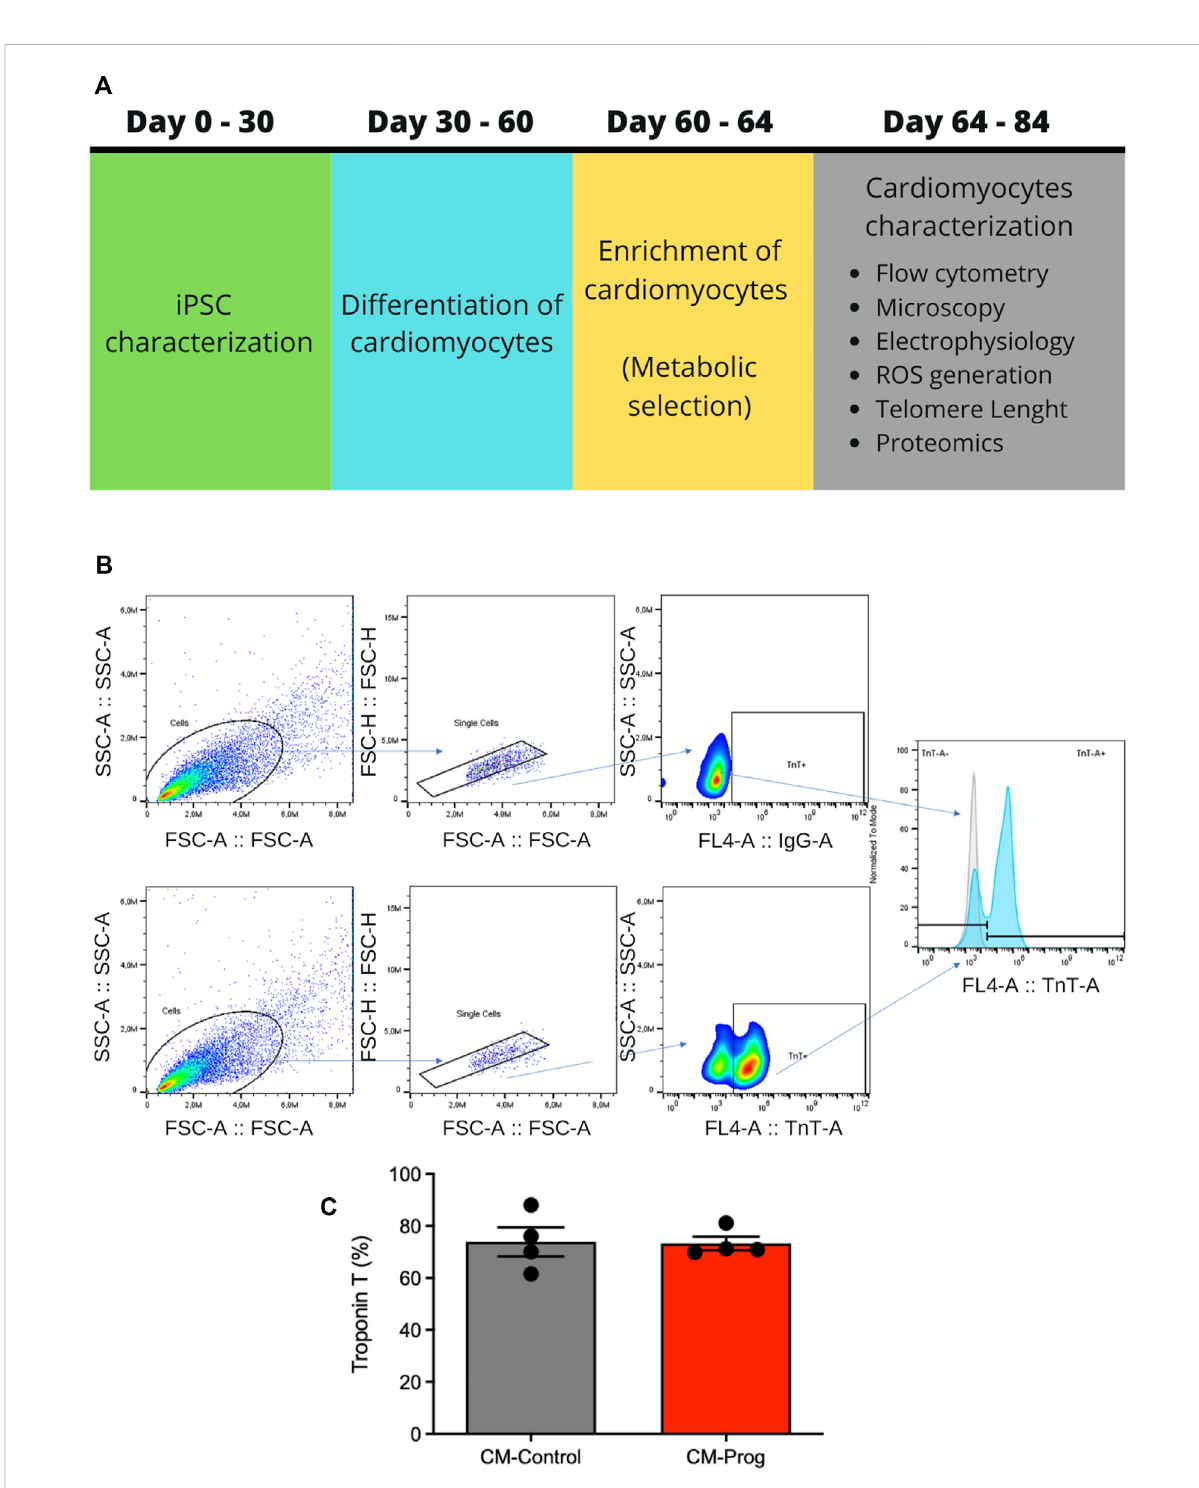
FIGURE 1 Study design and iPSC-derived cardiomyocyte generation (A) Schematic representation of the study design. (B) Gate strategy is shown in fl ow cytometry analysis of Troponin T (TnT) expression on cardiomyocytes derived from iPS cells. First, cells were gated by the scattering light pattern (forward scatter – FSC and side scatter – SSC), then single cells were selected and fi nally, the intensity of fl uorescence was determined by the secondary antibody staining. Cardiomyocytes stained only with secondary antibody (Alexa-Fluor 647). Cardiomyocytes stained with anti-TnT primary antibody followed by secondary antibody staining (Alexa-Fluor 647). Histogram overlap of secondary-stained (grey curve) and TnT-stained cells (blue curve). The x -axis shows the intensity of fl uorescence for TnT. (C) The ef fi ciency of cardiomyocyte generation in consecutive paired cellular differentiations. The columns represent the percentage of cardiac troponin T positive cells after differentiation, and the bars represent SEM, and non-parametric Mann-Whitney test was applied (CM-Control n = 4; CM-Prog n =